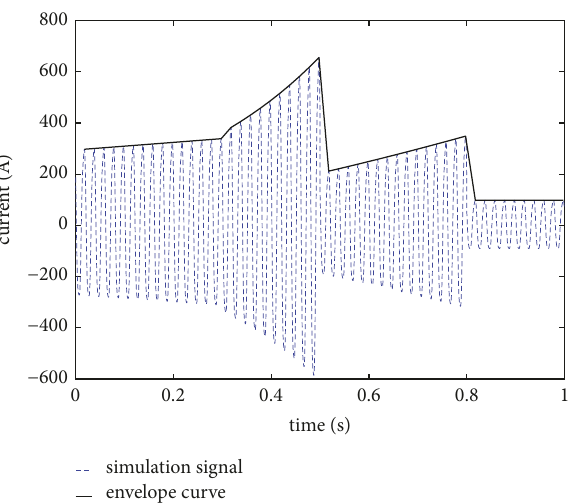
Figure 3: The envelope diagram of the dynamic signal.